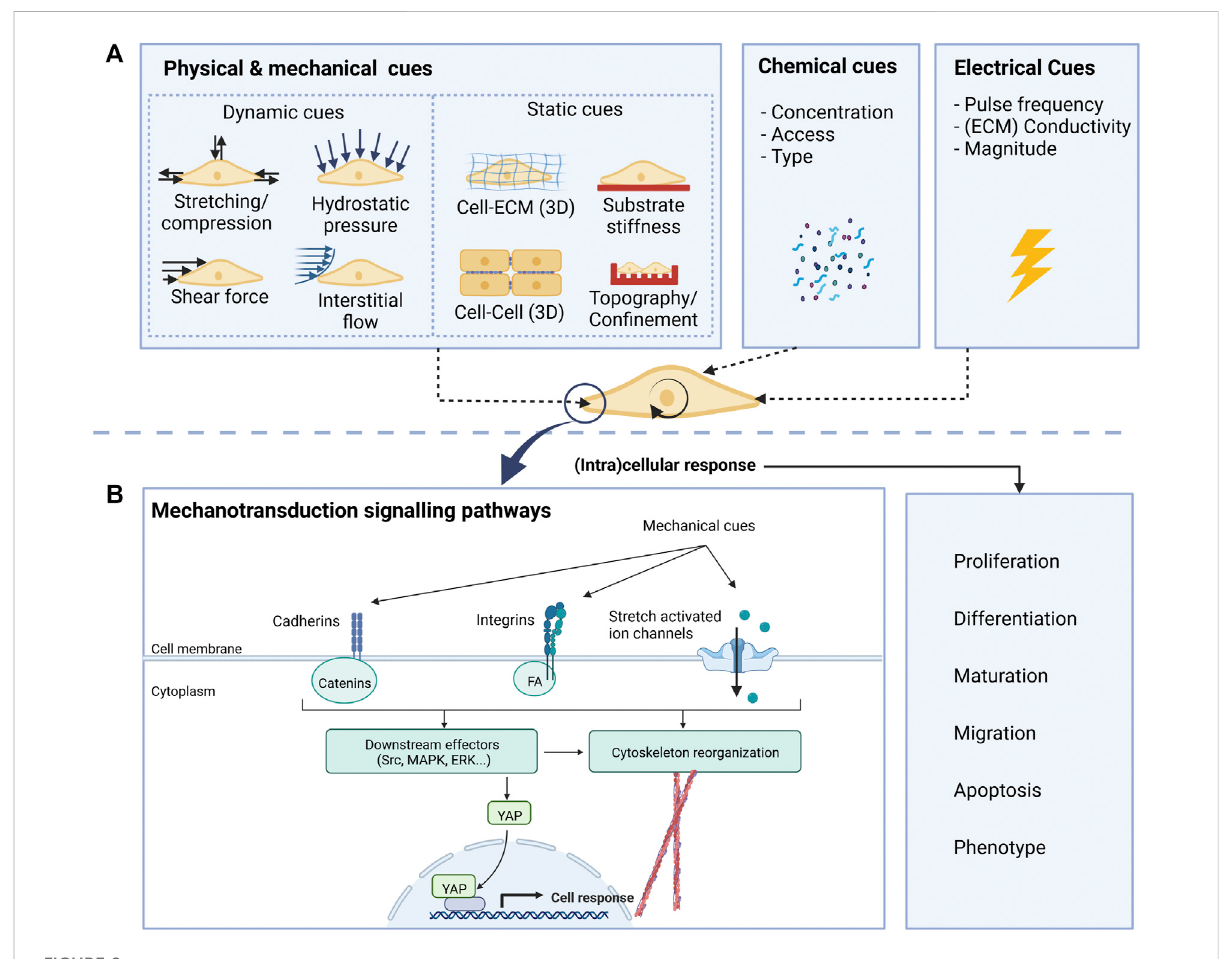
FIGURE 2 Overview of relevant cues (A) for neural cells and mechanotransduction pathways (B) .